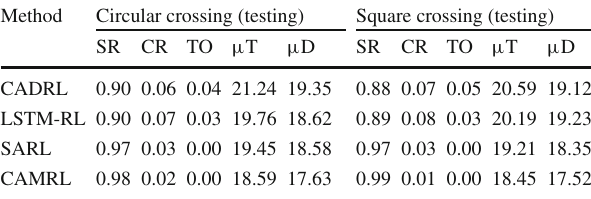
Table 6 Quantitative results of robot navigation in circular crossing and square crossing scenarios with 15 humans Method Circular crossing